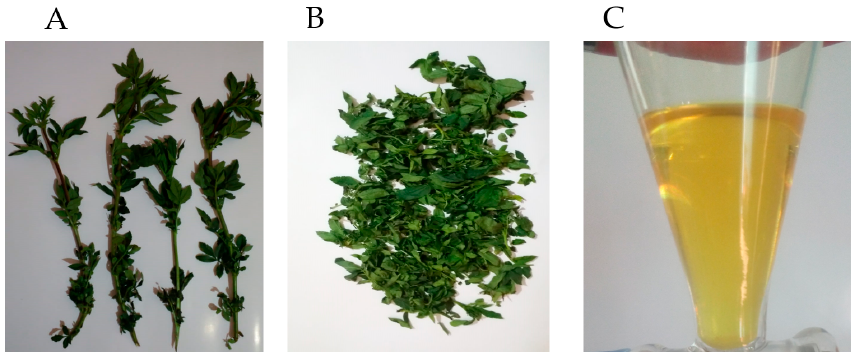
Figure 1. Tagetes elliptica ( A ) Stems and leaves; ( B ) Leaves; ( C ) Essential oil.